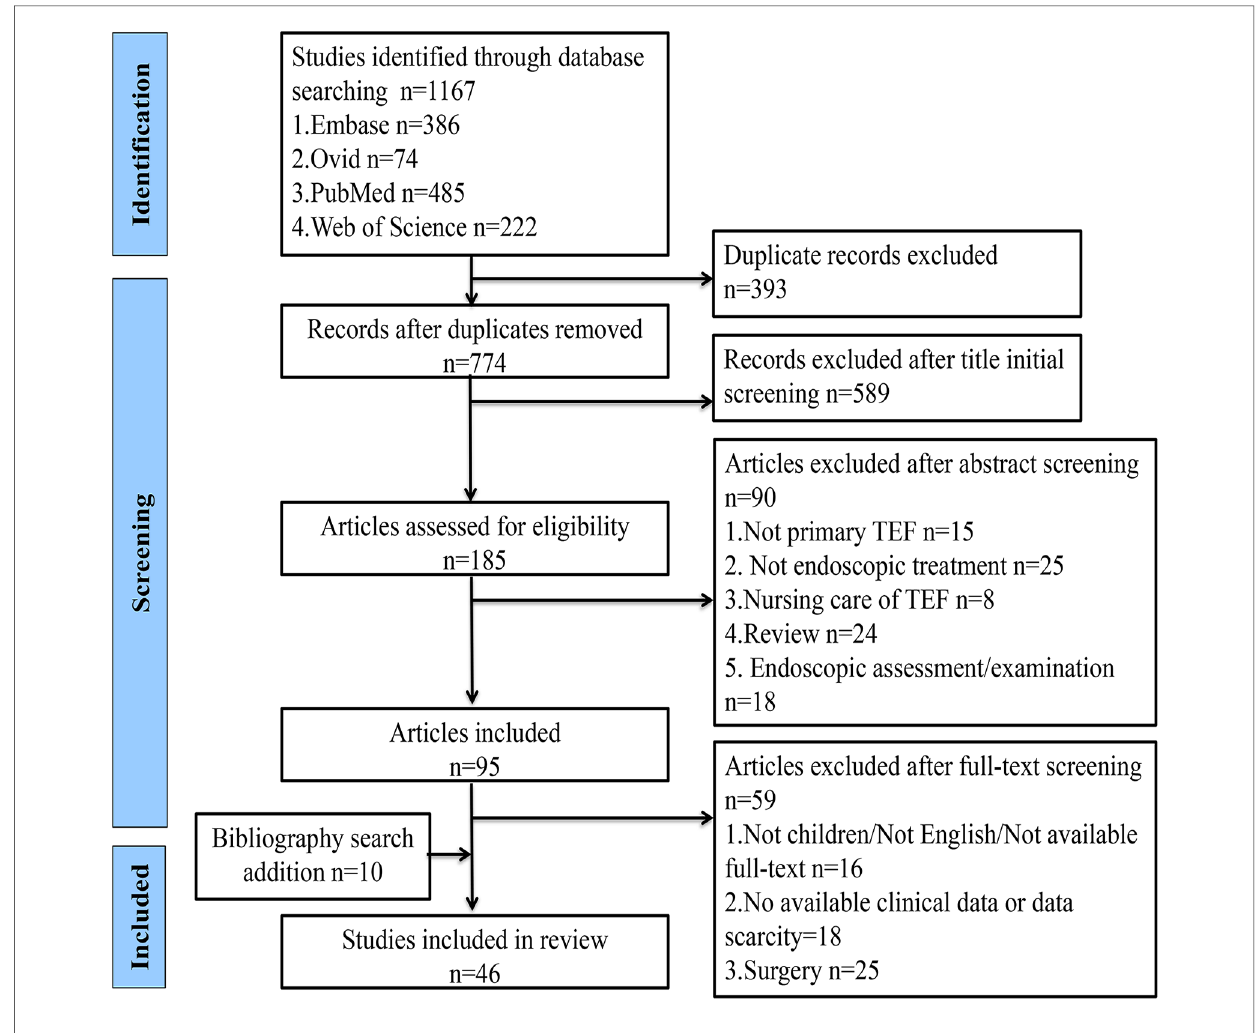
FIGURE 1 PRISMA fl ow diagram for systematic search and